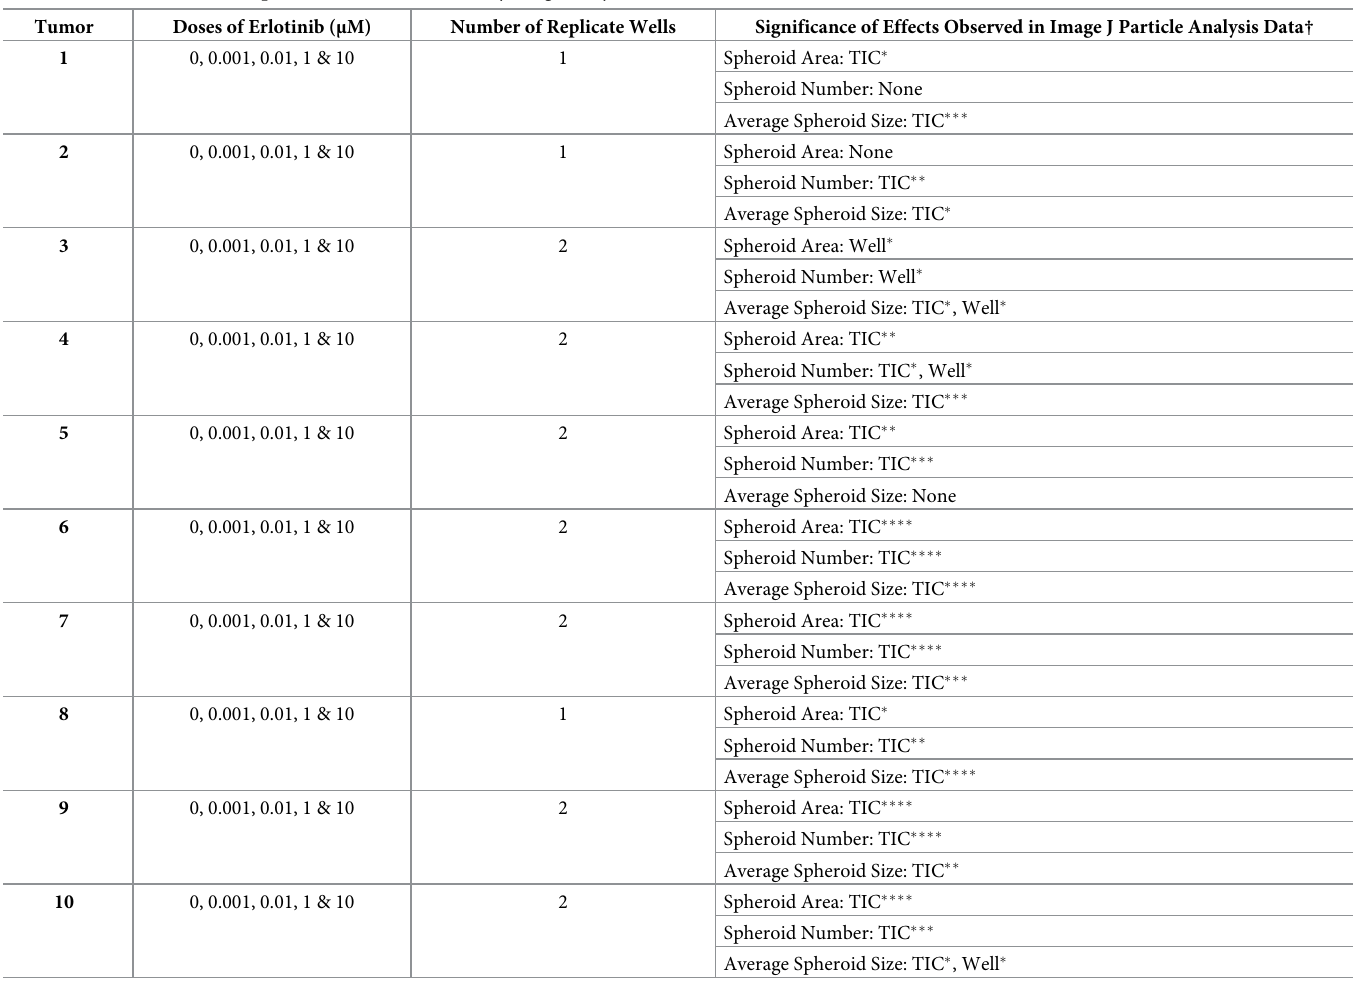
Table 2. Effects of short-term spheroid culture as assessed by image analyses. Tumor Doses of Erlotinib ( μ